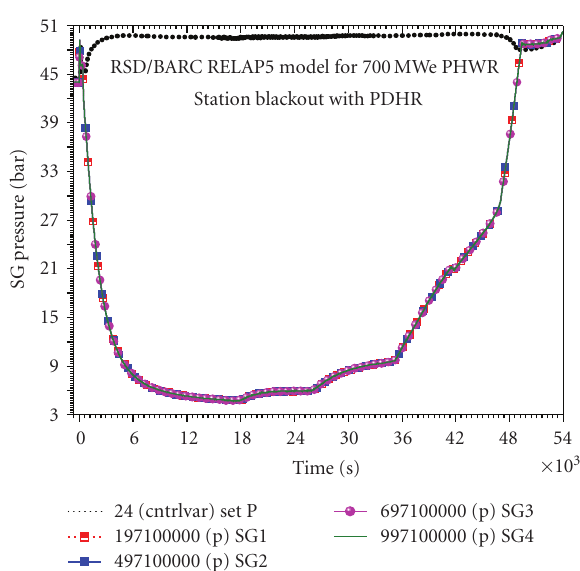
Figure 9: SG Pressure variation case-6 minutes delay in valving in PDHRS.